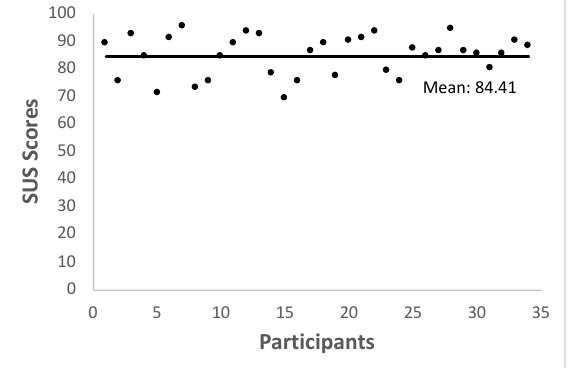
Figure 11. System Usability Scale (SUS) scores obtained from thirty four experts after using the proposed